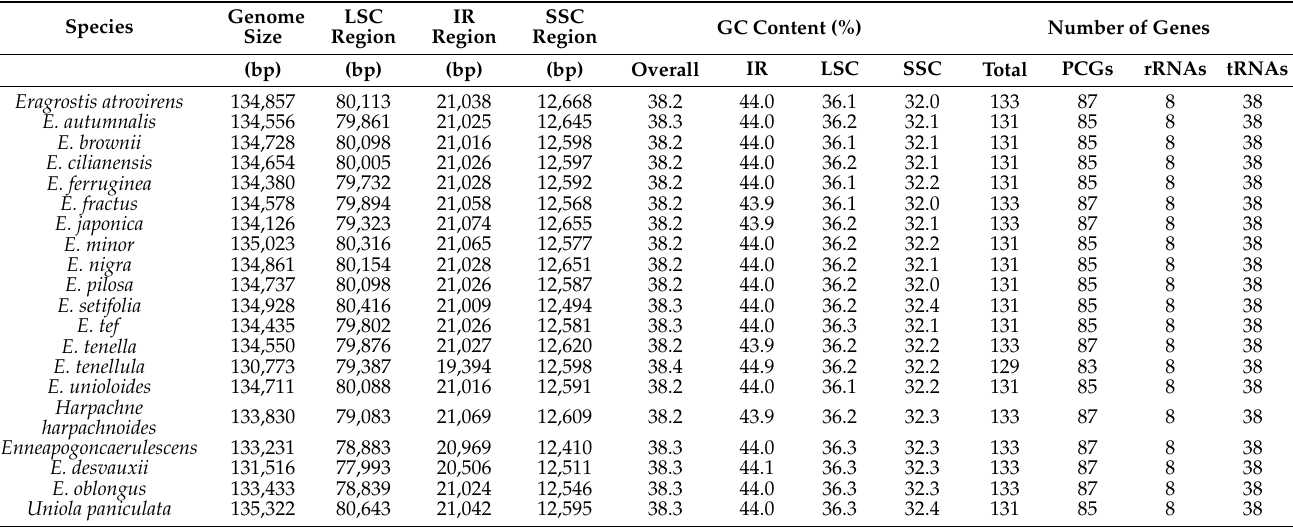
Table 2. Chloroplast genome characteristics of 20 Eragrostideae